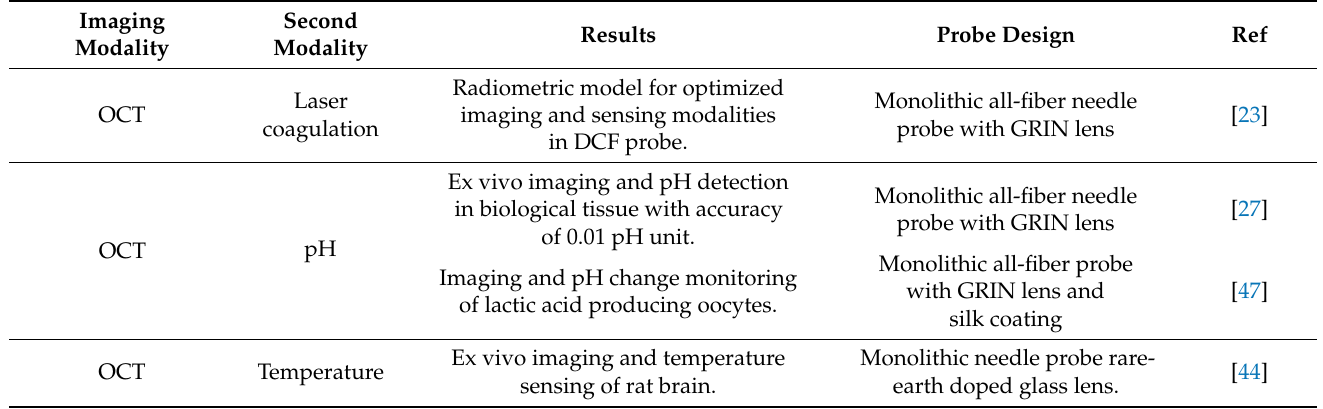
Table 2. Summary of published applications for DCF-based co-registered imaging, sensing, or therapeutic modalities post